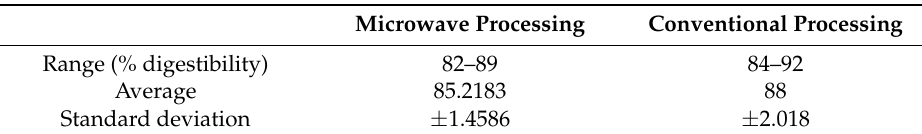
Table 4. Summarized statistics for in vitro protein digestibility of soymilk processing using process parameters according to central composite design.